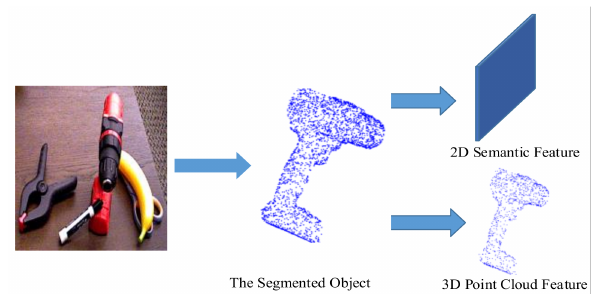
Figure 2. Framework of feature extraction algorithm. Objects are segmented from the instances in the images, and then 2D semantic features and 3D point cloud features are extracted respectively based on deep learning